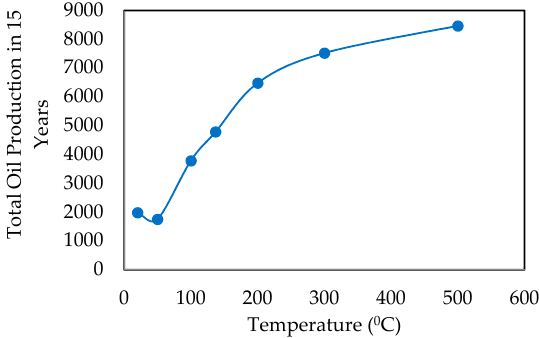
Figure 9. Variation of oil production with reservoir temperature.